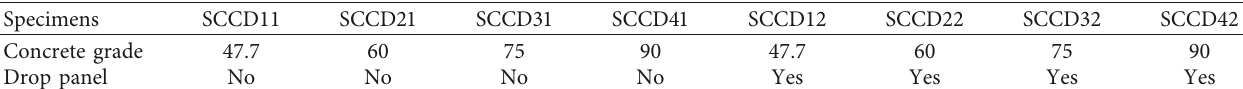
Table 4: The number of specimens for FE